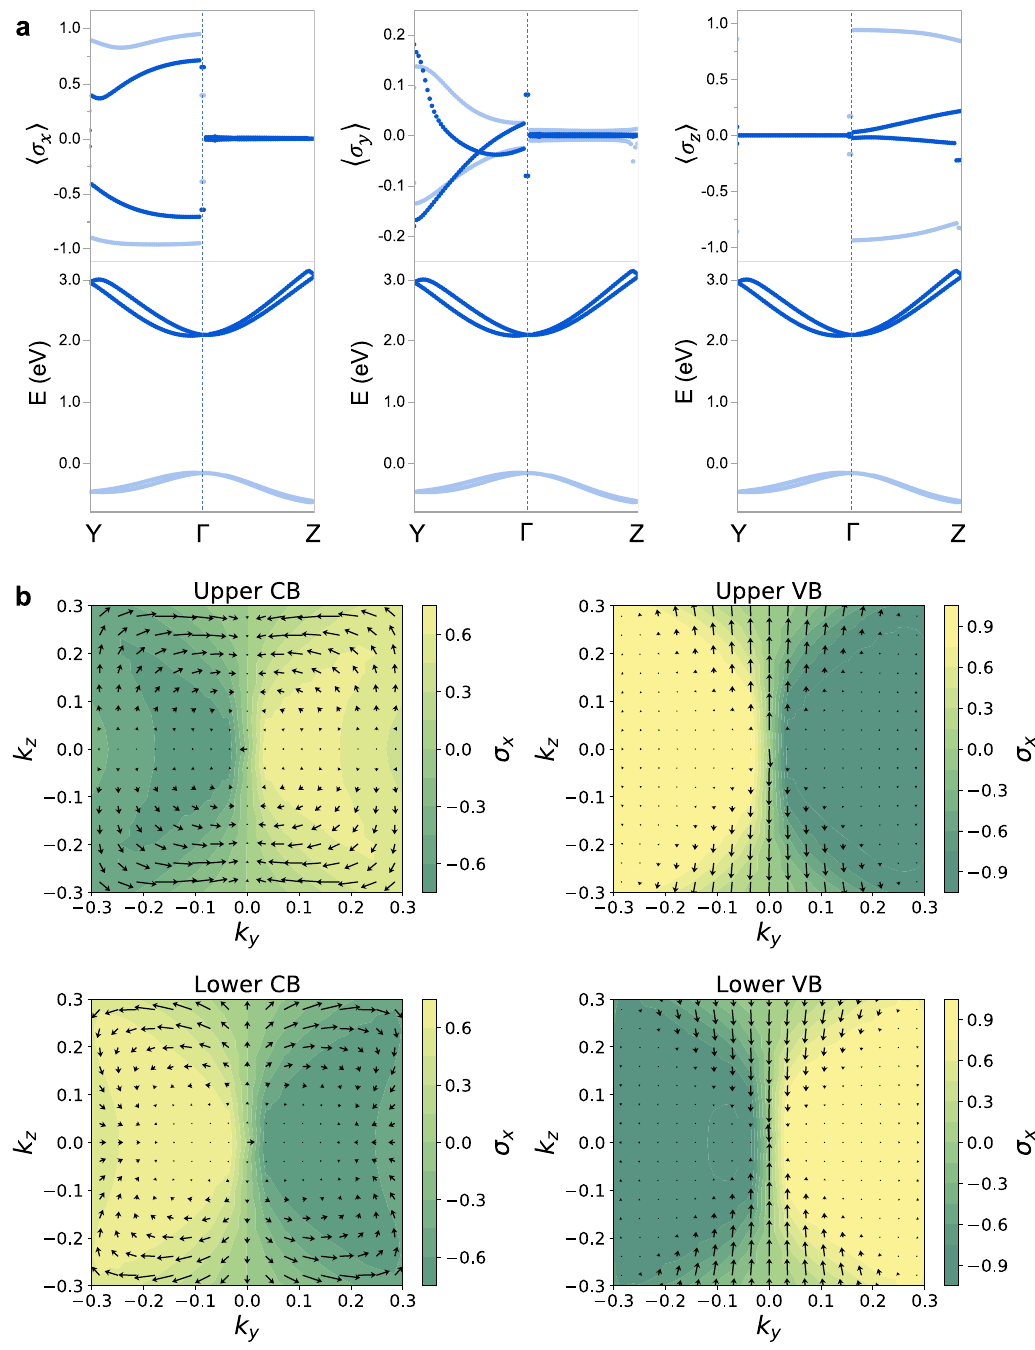
Fig. 4 Spin textures in [S-4-NO 2 -MBA] 2 PbBr 4 ∙ H 2 O. a PBE + SOC band structures (bottom panels) and momentum-dependent spin polarization (cid:5) (cid:6) (cid:5) (cid:6) (cid:5) (cid:6) (cid:5) (cid:6) (cid:5) (cid:6) components, σ x , σ y , and σ z (top panels), shown along the in-plane Γ (cid:3) Y and Γ (cid:3) Z paths. Here, σ y and σ z point along the two in-plane (cid:5) (cid:6) directions of the perovskite layer, while σ x points along the out-of-plane stacking direction. Only frontier conduction (CB) and valence bands (VB) derived from the metal halide framework are shown here. b Spin polarization of CB and VB subbands projected onto the reciprocal 2D plane perpendicular to the stacking direction. The arrows represent the in-plane components while the color scheme indicates the magnitude of the out-of-plane exemplify this point, (FC 2 H 4 NH 3 ) 2 PbCl 4 (P nma global space group symmetry with C 2 axis pointing along k , spin-splitting is z group) crystallizes with a center of inversion in-between the two exclusively along k with x -directed B , while k -related terms are eff y z inorganic layers comprising the unit cell 45 . Each inorganic layer is strictly forbidden by symmetry (Supplementary Table 7). Therefore, noncentrosymmetric (nominal P mc 2 1 layer group) owing to a large while the local inversion asymmetry (i.e., owing to a large Δ β ) Δ β . The local inversion asymmetry of the inorganic layer leads to induces spin-splitting, the global symmetry governs the speci fi cs of CB splitting, but the global inversion symmetry leads to a zero net k-dependent spin-splitting and spin polarizations. To further